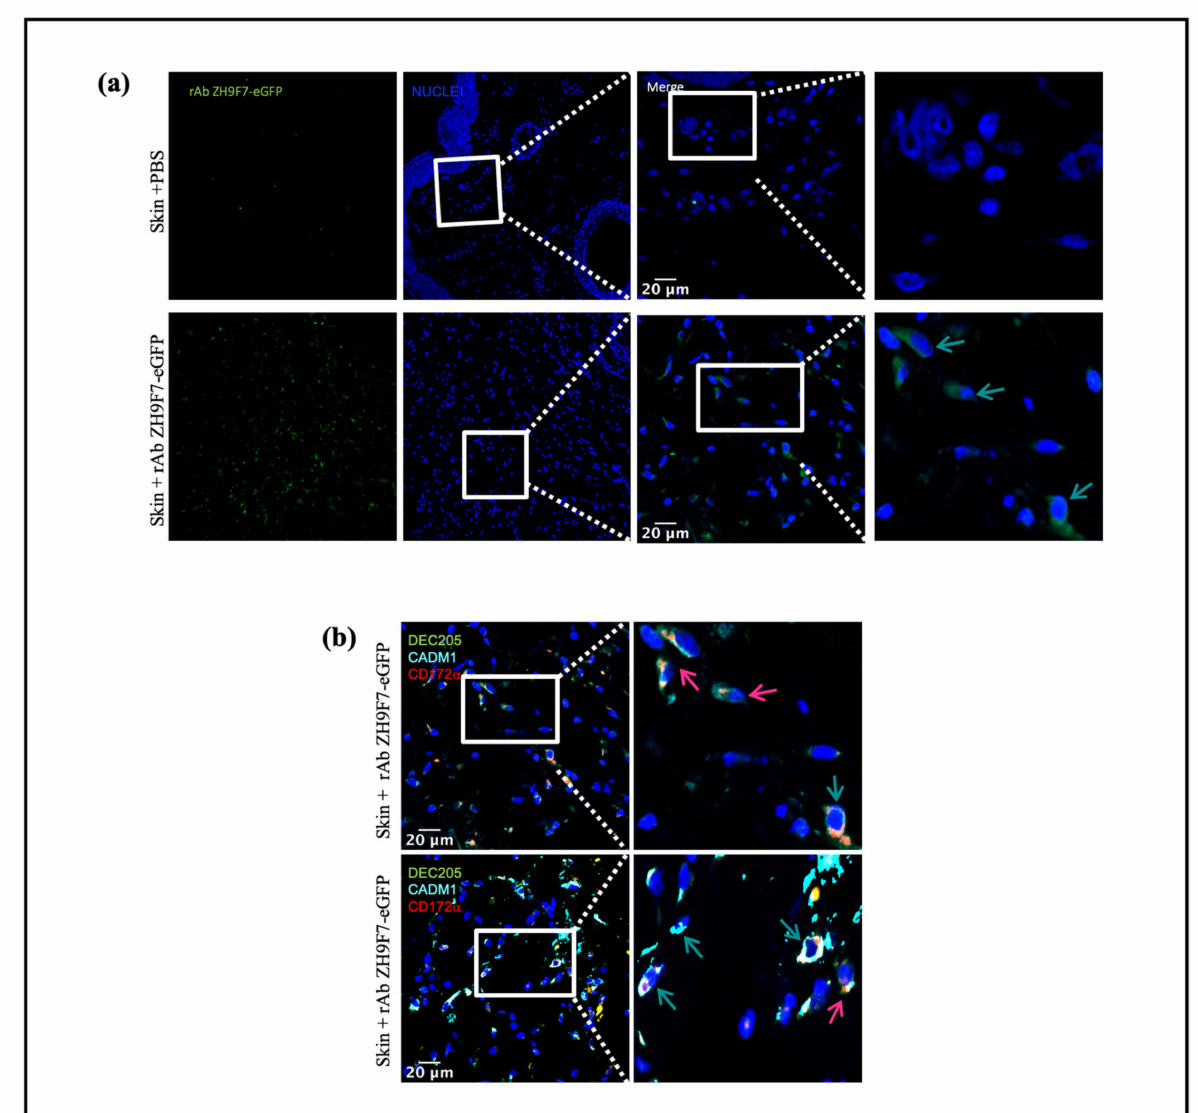
Figure 6. Skin DEC205 targeted DCs. Representative immunofluorescence micrographs from targeted DEC205 DCs were evaluated. ( a ) Control and rAb ZH9F7-eGFP treated skin DEC205 + cells (green) are shown in left panels, and zoomed areas (scale bar 20 µ m) are shown in right panels. Identification of targeted DEC205 DC subsets by expression of ( b ) DEC205 + CADM1 + , cDCs1 (pink arrows) and DEC205 + CADM1 + CD172a + , cDCs 2 (bluish-green arrow). Representative immunofluorescence micrographs from a zoomed area (scale bar = 20 µ m). Data from different regions of